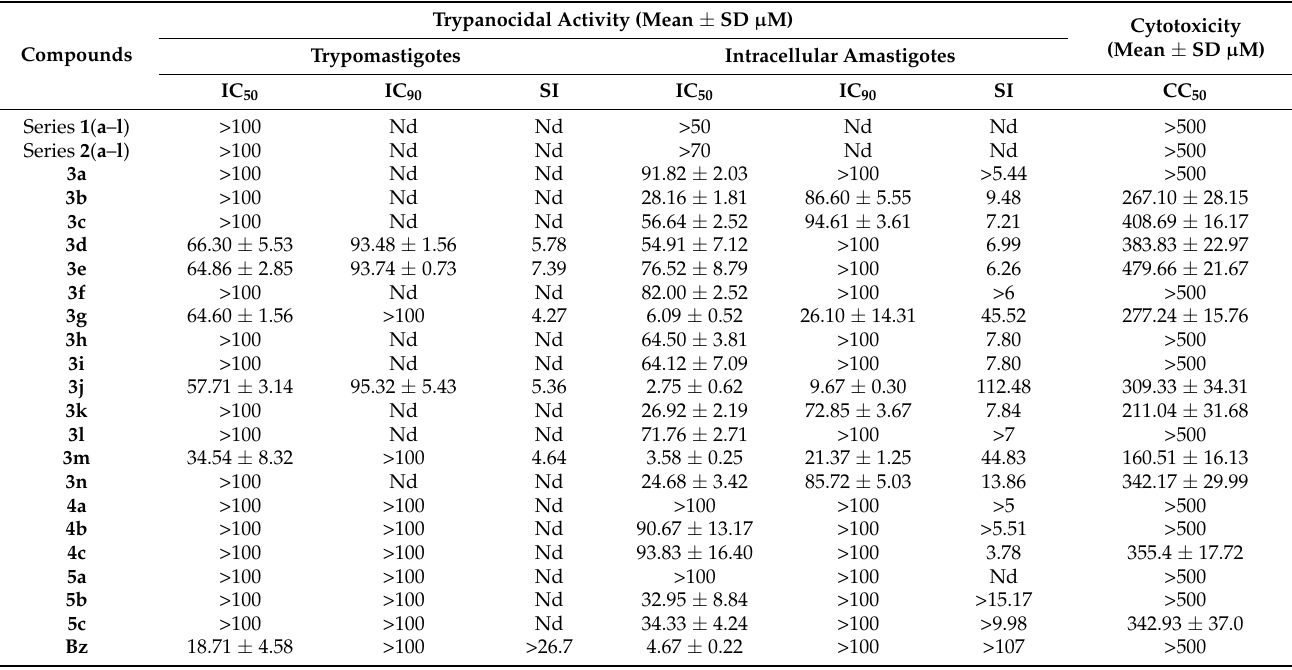
Table 1. Cytotoxicity and trypanocidal effect of pyrazoles